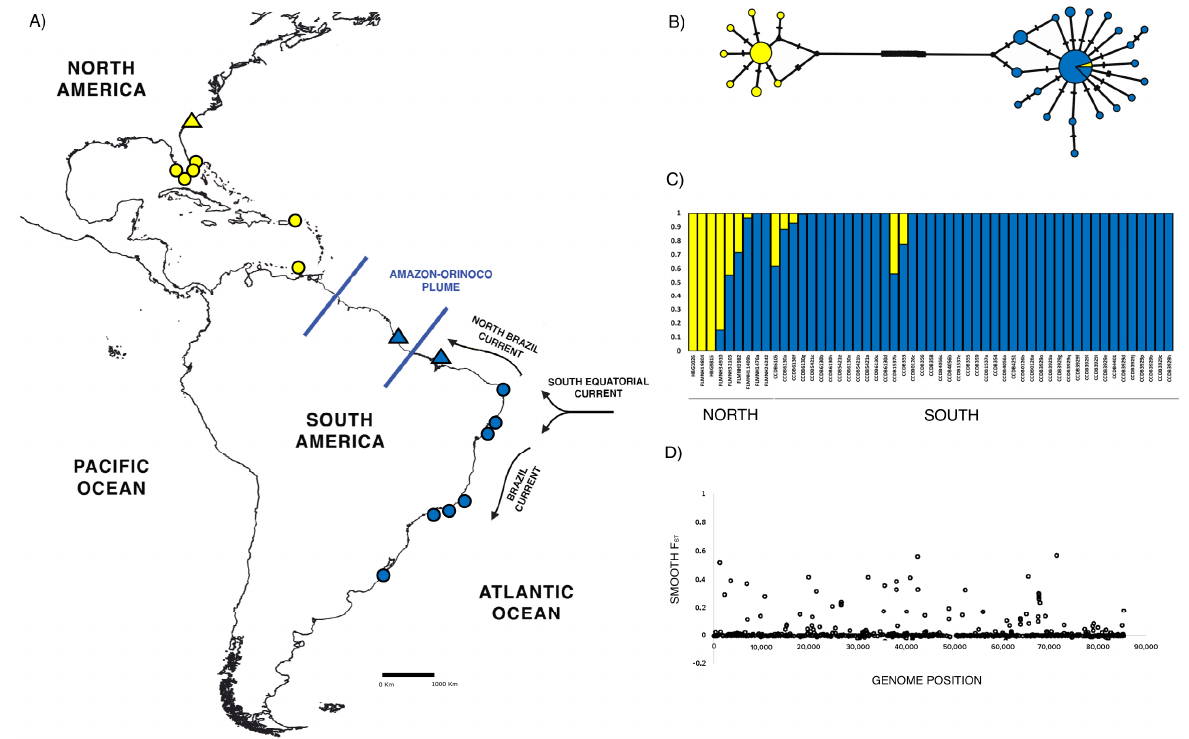
Figure 2. ( A ) Map of the western Atlantic showing Callinectes ornatus sampling localities. Circles represent the localities used for ddRAD-seq analyses; triangles represent COI new sequences added to [25]’s dataset. Yellow: north group; blue: south group. Blue lines represent the Amazon River and Orinoco River mouth, resulting in the Amazon–Orinoco Plume. Arrows represent oceanic currents; ( B ) haplotype network result for C. ornatus . The size of the network circles is proportional to the haplotype frequency. Crossed lines indicate the number of substitutions between haplotypes. Colors represent the region from where the haplotype was sampled. North group: yellow; south group: blue. Individuals from within the AOP region are represented in a separate section in the central haplotype of the south group. Twenty substitutions separate the two networks ( C ) STRUCTURE plot resulting from the analysis of C. ornatus individuals. Each vertical bar represents an individual. Different colors represent different genetic clusters (K). The voucher numbers of each individual and geographic location are indicated under the plot. ( D ) Smooth F ST across the genome by calculating kernel- smoothed F ST considering a sliding window of 900 Kbp. Each circle represents a genome